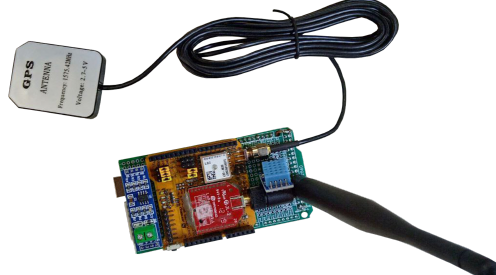
Figure 3. SX1276 module coupled to an Arduino